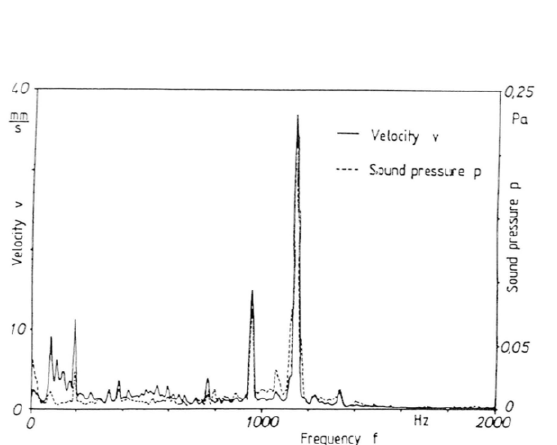
FIGURE 3 Absolute vibration amplitude and fre quency obtained by means of the